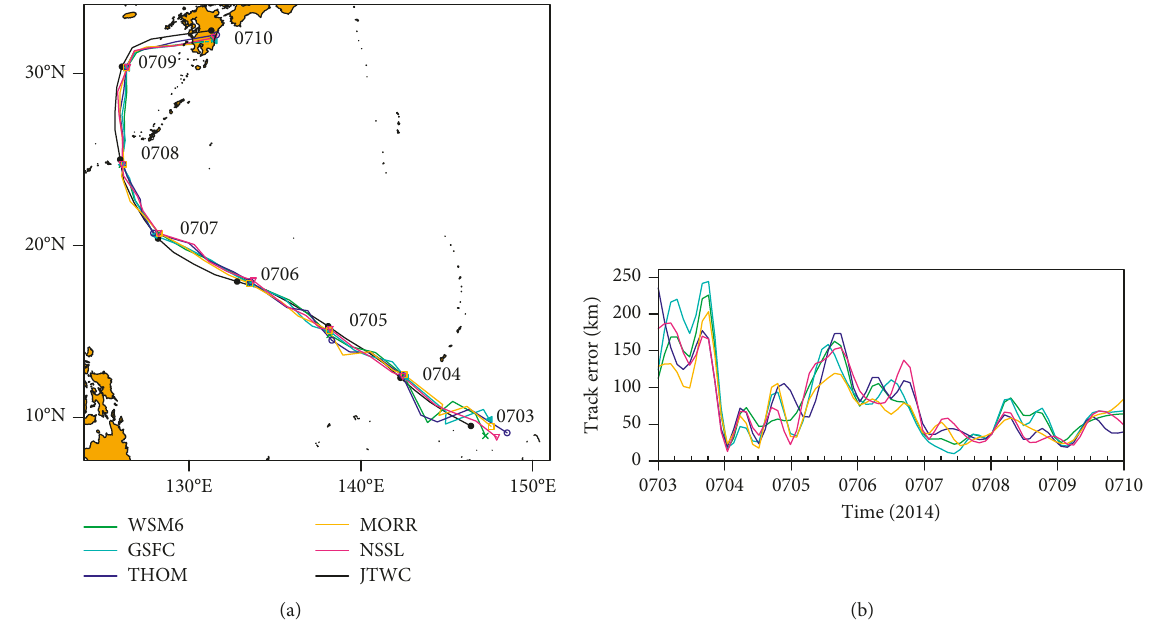
Figure 2: Spatial distribution of the typhoon track from model simulations during 0000 UTC 3 Jul to 0000 UTC 10 July 2014 at 6h intervals, compared with (a) the JTWC best-track data and (b) the corresponding time series of simulated track errors with respect to the best track from JTWC. The simulations began at 1200 UTC each day from 2 to 8 July 2014 and then integrated forward for 36hours, with 12-hour spin- up